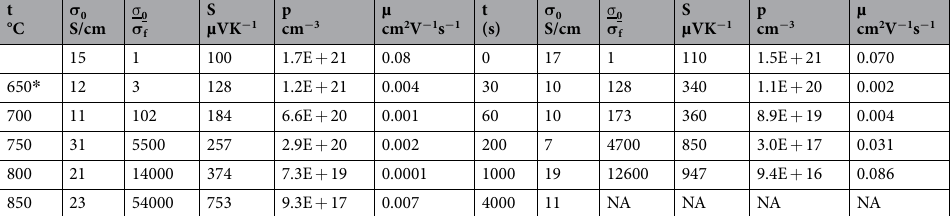
Table 1. Annealing times or annealing temperatures, initial electrical conductivities and the ratios after thermal treatment, Seebeck coefficients and calculated carrier’s concentration and mobility (within small polaron model) for: left - films annealed for 900 s at different temperatures ( * sample annealed for 3600 s); right - films annealed at 900 °C for different time intervals. NA – measures beyond the sensitivity of our